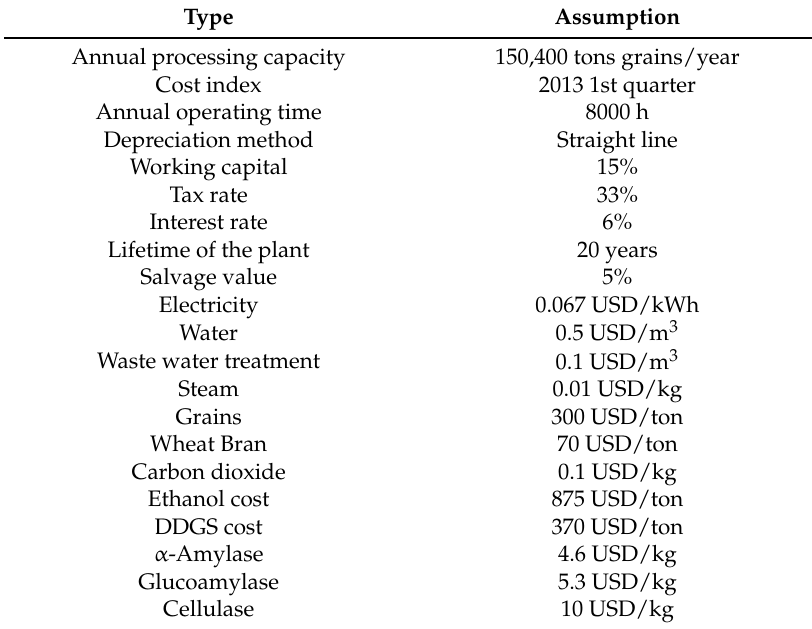
Table 2. Economic indicators used in this